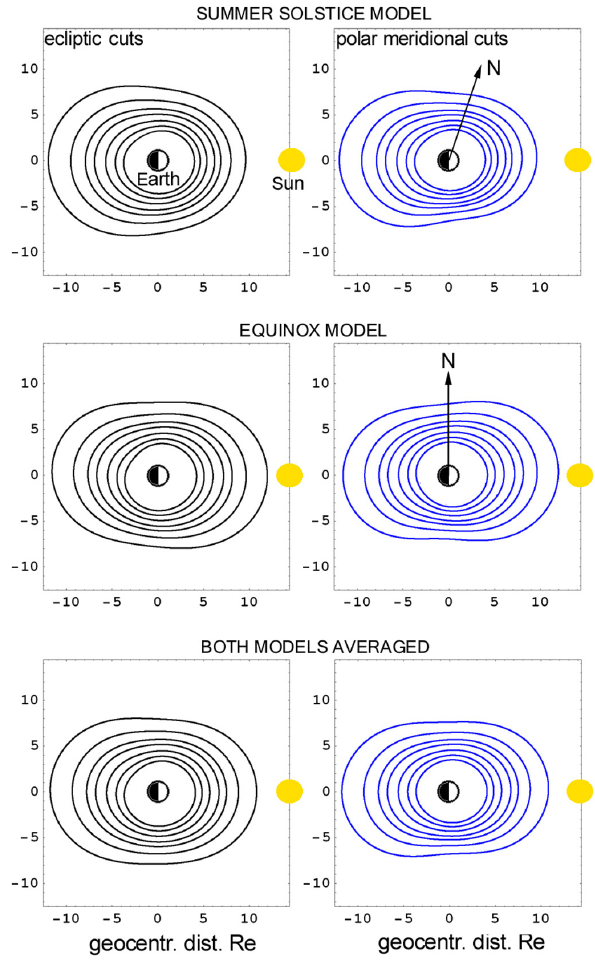
Fig. 8. Geocoronal H-density distribution fits for summer solstice (top), equinox (middle) and both averaged (bottom) separately as ecliptic cut (left side) and polar meridional cut (right side). The den- sity contours for all 6 images are from outside to inside: 30, 50, 75, 100, 150, 225, 337cm − 3 .